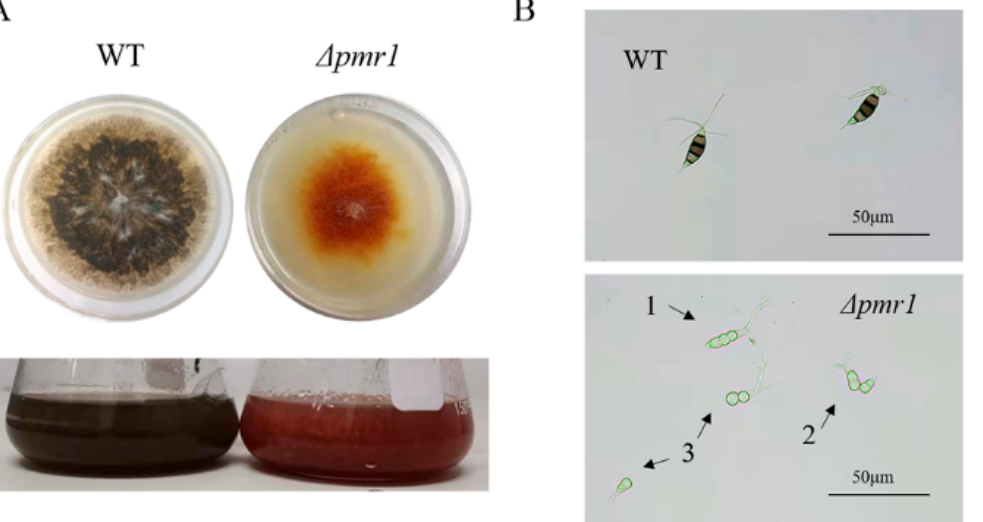
Figure 3. Pmr1 regulates melanin biosynthesis and conidial morphogenesis in P. microspore . ( A ) Phenotype of P. microspore WT and Δ pmr1 strains. Both strains were cultivated on PLA or in PLB for 7 days at 28 °C. The colonies of Δ pmr1 strain turned burgundy, and that of WT was in dark. ( B ) Morphology of conidia produced from WT and Δ pmr1 mutant. The original 5-celled fusiform conidia (upper panel) were deformed in Δ pmr1 (bottom panel).